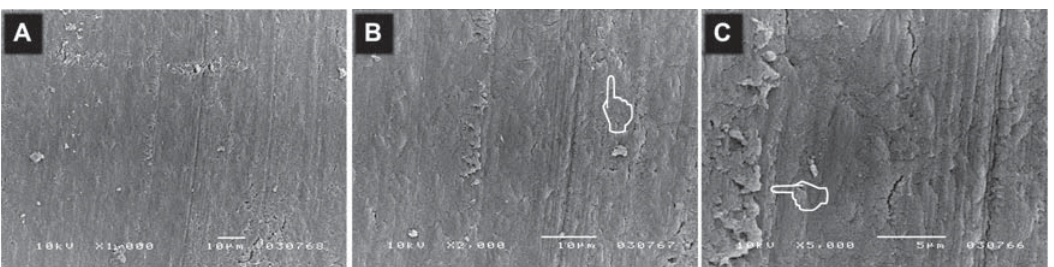
Figure 1- Scanning electron microscopy showing the morphology of the root surfaces treated with hand curettes. A: mechanical periodontal treatment with curettes creates a compact and multilayered smear layer characterized by the presence (cid:2)(cid:3)(cid:4)(cid:5)(cid:6)(cid:7)(cid:8)(cid:9)(cid:10)(cid:11)(cid:12)(cid:13)(cid:14)(cid:4)(cid:3)(cid:6)(cid:9)(cid:9)(cid:2)(cid:15)(cid:5)(cid:16)(cid:4)(cid:17)(cid:4)(cid:18)(cid:19)(cid:20)(cid:21)(cid:22)(cid:22)(cid:22)(cid:23)(cid:4)(cid:13)(cid:24)(cid:25)(cid:4)(cid:26)(cid:4)(cid:18)(cid:19)(cid:27)(cid:21)(cid:22)(cid:22)(cid:22)(cid:23)(cid:28)(cid:4)(cid:29)(cid:30)(cid:4)(cid:31)(cid:12)!(cid:31)(cid:8)(cid:9)(cid:4)"(cid:13)!(cid:24)(cid:12)(cid:10)(cid:11)(cid:13)(cid:30)(cid:12)(cid:2)(cid:24)(cid:4)(cid:12)(cid:30)(cid:4)(cid:12)(cid:5)(cid:4)(cid:7)(cid:2)(cid:5)(cid:5)(cid:12)#(cid:14)(cid:8)(cid:4)(cid:30)(cid:2)(cid:4)(cid:11)(cid:14)(cid:8)(cid:13)(cid:9)(cid:14)$(cid:4)(cid:2)#(cid:5)(cid:8)(cid:9)%(cid:8)(cid:4)(cid:13)(cid:4)(cid:25)(cid:12)(cid:5)(cid:30)(cid:12)(cid:24)!(cid:6)(cid:12)(cid:5)(cid:31)(cid:8)(cid:25)(cid:4) "(cid:2)(cid:9)(cid:7)(cid:31)(cid:2)(cid:14)(cid:2)!$(cid:4)(cid:5)(cid:12)"(cid:12)(cid:14)(cid:13)(cid:9)(cid:4)(cid:30)(cid:2)(cid:4)(cid:30)(cid:31)(cid:13)(cid:30)(cid:4)(cid:2)(cid:3)(cid:4)’(cid:30)(cid:9)(cid:8)(cid:8)(#(cid:13)(cid:9))*(cid:4)(cid:18)(cid:7)(cid:2)(cid:12)(cid:24)(cid:30)(cid:8)(cid:9)(cid:23)(cid:4)(cid:12)(cid:24)(cid:25)(cid:6)(cid:11)(cid:8)(cid:25)(cid:4)#$(cid:4)(cid:30)(cid:31)(cid:8)(cid:4)(cid:15)(cid:2)(cid:9))(cid:12)(cid:24)!(cid:4)(cid:5)(cid:30)(cid:9)(cid:2))(cid:8)(cid:5)(cid:4)(cid:2)(cid:3)(cid:4)(cid:30)(cid:31)(cid:8)(cid:4)(cid:11)(cid:6)(cid:9)(cid:8)(cid:30)(cid:30)(cid:8)/(cid:4)6(cid:2)(cid:4)(cid:8);(cid:7)(cid:2)(cid:5)(cid:8)(cid:25)(cid:4)(cid:25)(cid:8)(cid:24)(cid:30)(cid:12)(cid:24)(cid:4)(cid:30)(cid:6)#(cid:6)(cid:14)(cid:8)(cid:5)(cid:4) were observed subsequent to the mechanical periodontal treatment with curettes